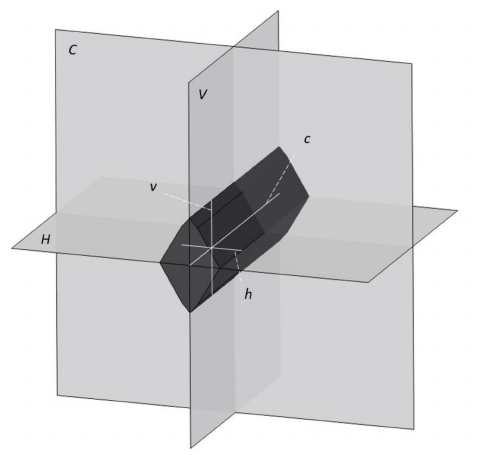
Figure 3. Planes and axes that are further used for describing the locations where measurements are done.